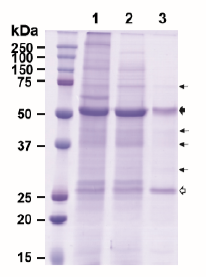
Figure 2. Aqueous two-phase separation (ATPS)-based purification of E16 mAb from N. benthamiana leaves. Total soluble proteins were extracted from plants and E16 was purified by ATPS (Lanes 1–3) or Protein A affinity chromatograph (Lanes 4-6), analyzed on a 12% SDS-PAGE gel under reducing conditions, and visualized with Coomassie stain. Lane 1, total leaf soluble proteins; Lane 2, proteins in the upper aqueous phase of ATPS; Lane 3, ATPS-enriched E16; Lane 4, leaf soluble proteins after low pH precipitation; Lane 5, Protein A flow through; Lane 6, Protein A column-purified E16.